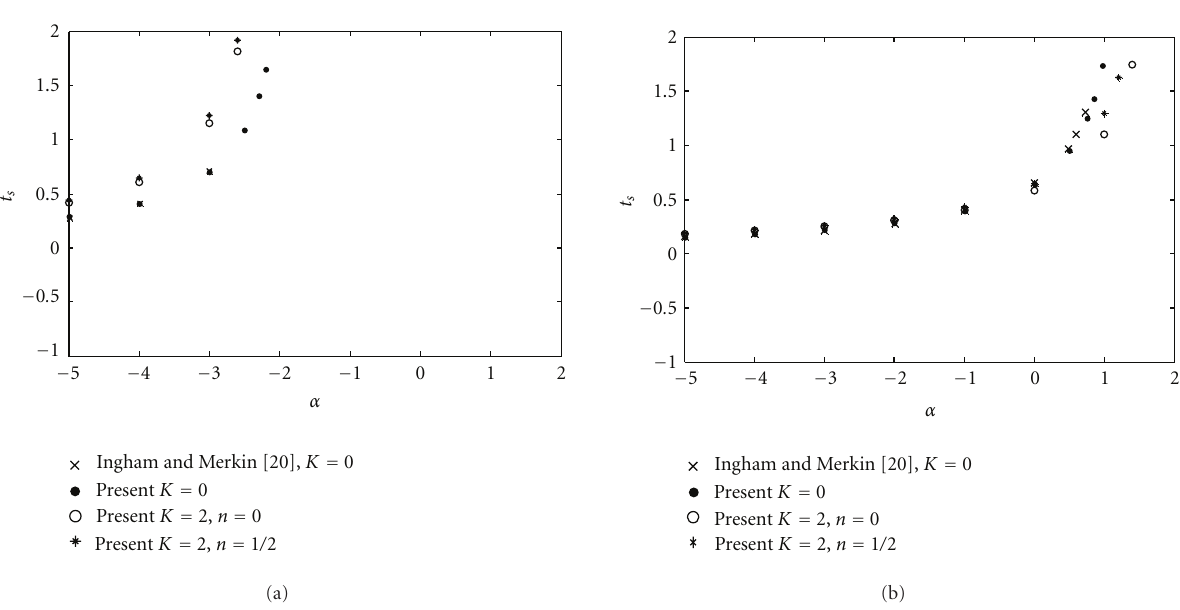
Figure 2: Variation of the separation times with α near: (a) forward and (b) rear stagnation points when Pr = 1 for K = 0, 2 and n = 0, 1 / 2.